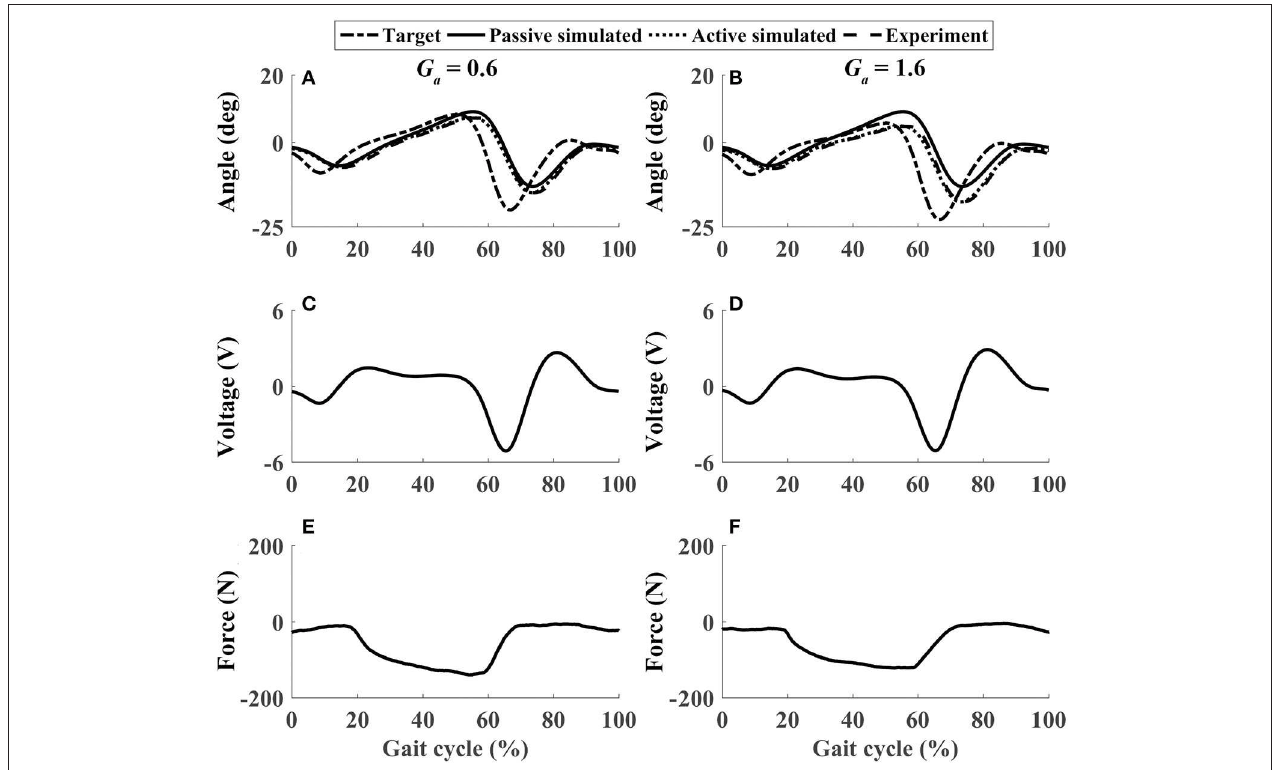
FIGURE 11 | The performance of P1 when he pushed down his foot voluntarily during the whole gait cycle (Case 4). (A,B) Ankle joint trajectories. (C,D) Input voltage. (E,F) Active force.